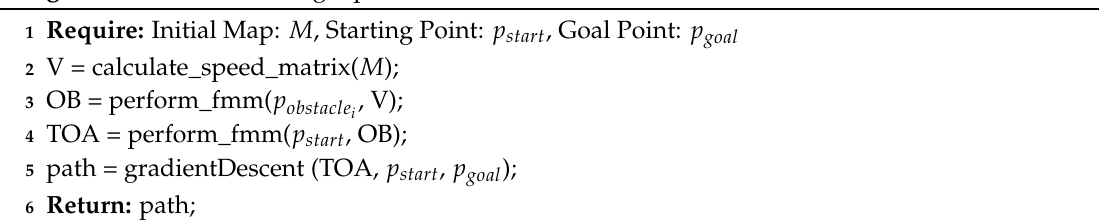
Figure 8. FMS sequence diagram. Algorithm 8: Fast Marching Square